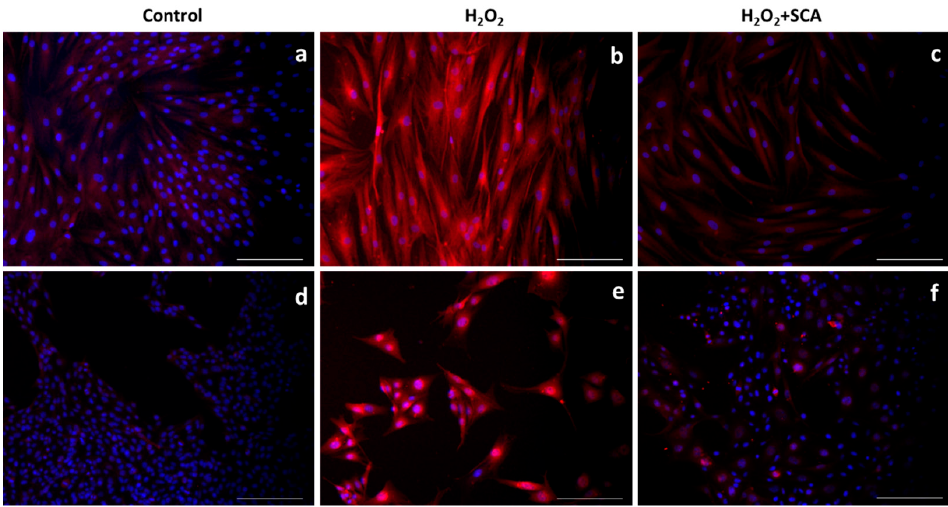
Figure 7. SCA ® significantly reduced CML immunostaining in H 2 O 2 -exposed cells. Representative inverted fluorescence microscopy images immunostained with anti-CML antibody in red. Nuclei were stained with Hoechst probe in blue. Fibroblasts ( a – c ) and B16-F10 cells ( d – f ) exposed to H 2 O 2 ( b , e ) and H 2 O 2 -exposed cells and treated with SCA ® ( c , f ). Scale bars: 200 µm.